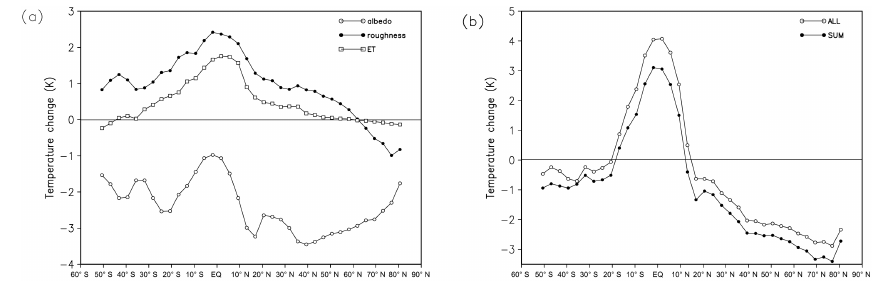
Figure 10. Panel (a) : latitudinal patterns of the contribution of individual biophysical factors to temperature change and (b) reconstructed